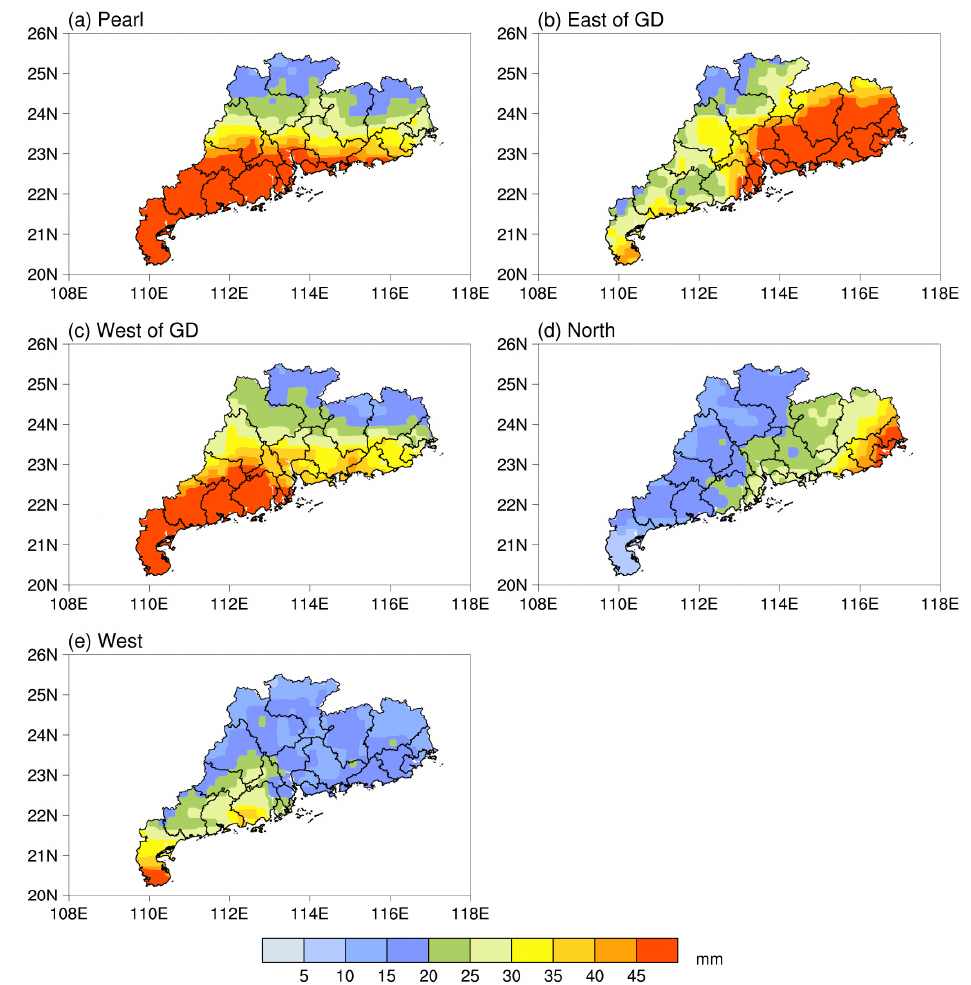
Figure 4. Averaged spatial distribution of cumulative precipitation during the 24 h before through the 24 h after typhoons made landfall (for non-landing typhoons, data accumulated over the time from 24 h before through 24 h after the time at which the typhoon most closely approaches the coast of